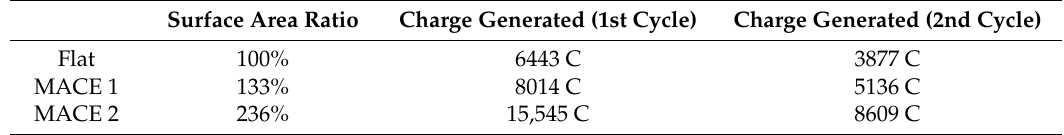
Table 3. Comparison of the amounts of photosynthetic electrons from three different